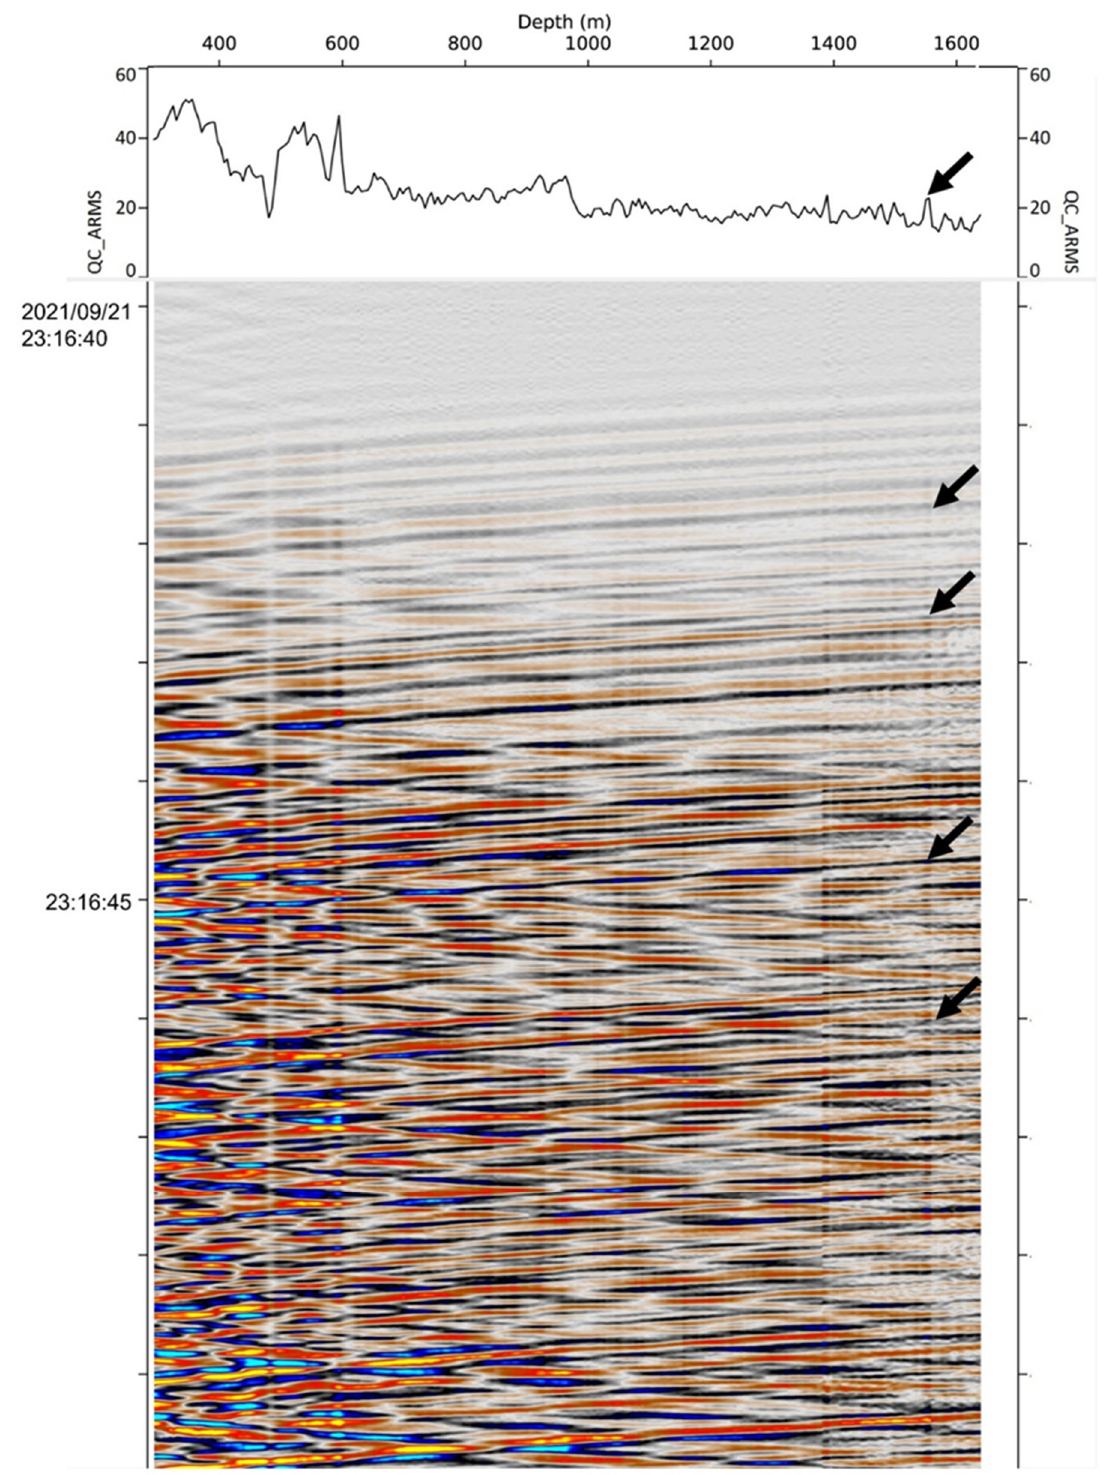
Figure 8. CRC-3 DAS gather of the M5.9 Mansfield Earthquake (21 September 2021). Graph above the gather shows RMS amplitude in a 1 s window around the first P-wave arrival. Arrows indicate the CO 2 injection interval.